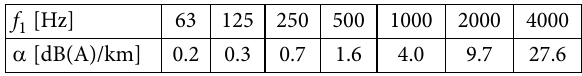
Table 4. Indicators for planning measures to combat